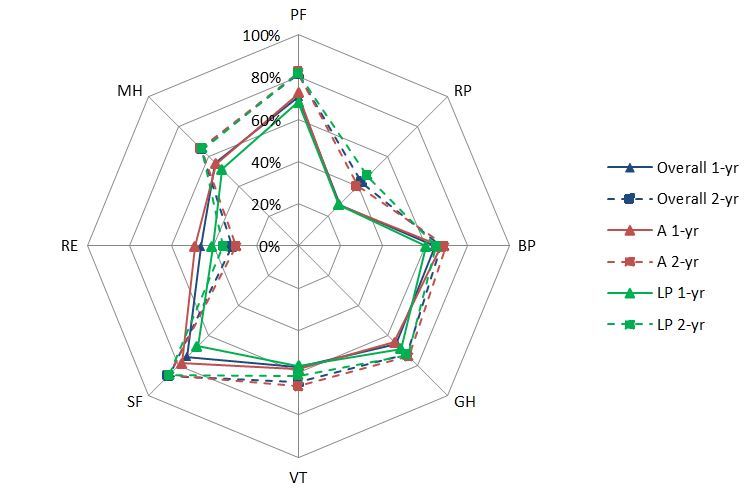
A: amputees; LP: Limb preservation; yr: year; mo: month; PF: Physical
Functioning, RP: Role Physical, BP: Bodily Pain, GH: General Health, VT:
Vitality, SF: Social Functioning, RE: Emotional Role, MH: Mental Health.
Definitions:Physical subscale = mean of PF, RP, BP and GH; Mental
subscale = mean of VT, SF, RE, MH; SF 36 score is improving from inner
(0%) to outer (100%). At 1-year: overall n = 254, A: n= 161, LP: n= 93;
At 2-year: overall: n = 204, A: n= 127, LP: n=77